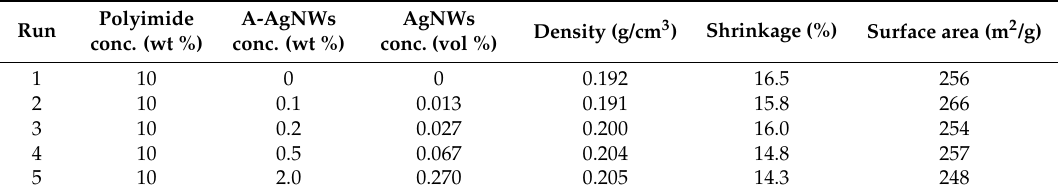
Table 1. Formulation and properties of aerogels with different A-AgNWs